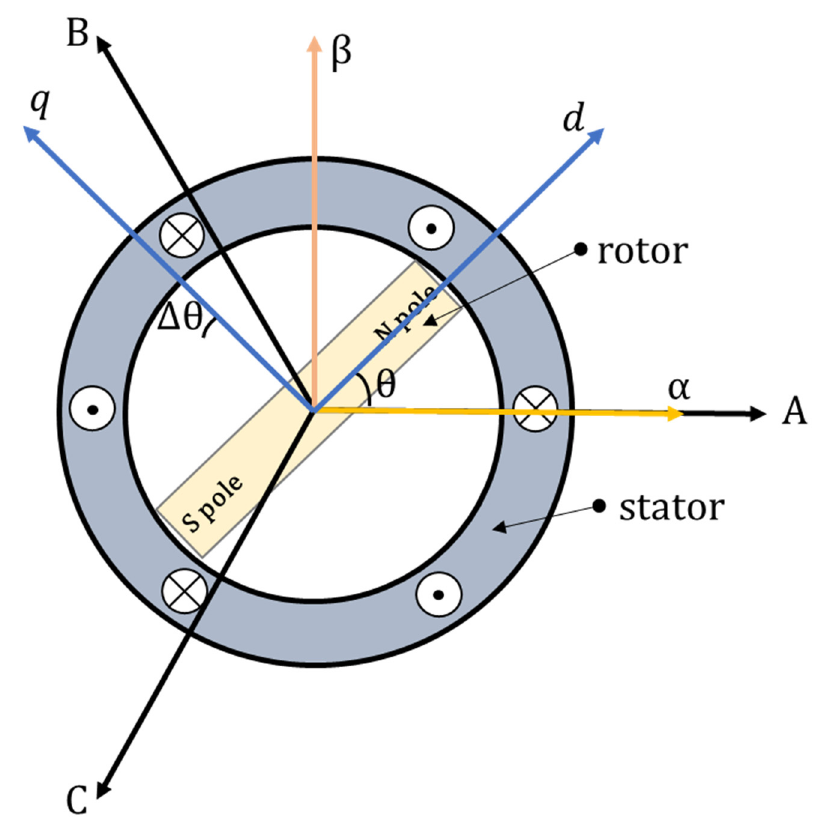
Figure 1. Common coordinates of SPMSM.